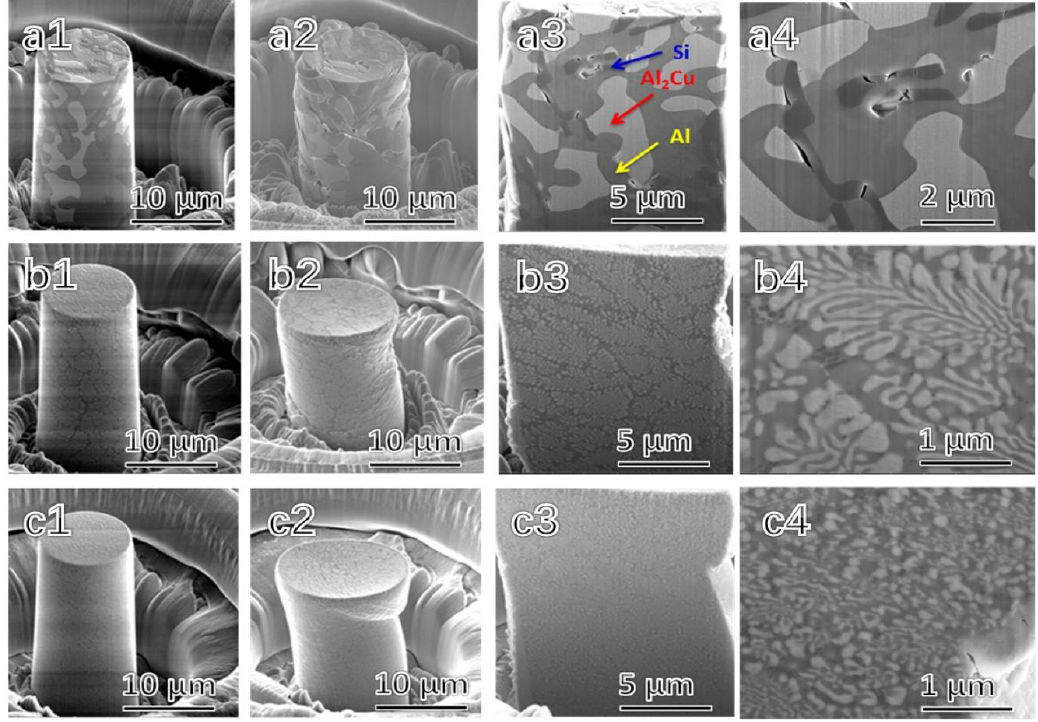
Figure 3. Marco- and micro-structures of the Al – Al 2 Cu – Si pillars before and after compression test; ( a1 – c1 ) the as-cast, laser treated, refined laser remelted pillars before compression; ( a2 – c2 ) the pillars after compression; ( a3 – c3 ) the cross-section of the pillars after compression; ( a4 – c4 ) the high magnification images of the images from a3 – c3. All the images were captured in the SEM with a tilt angle of 52°.